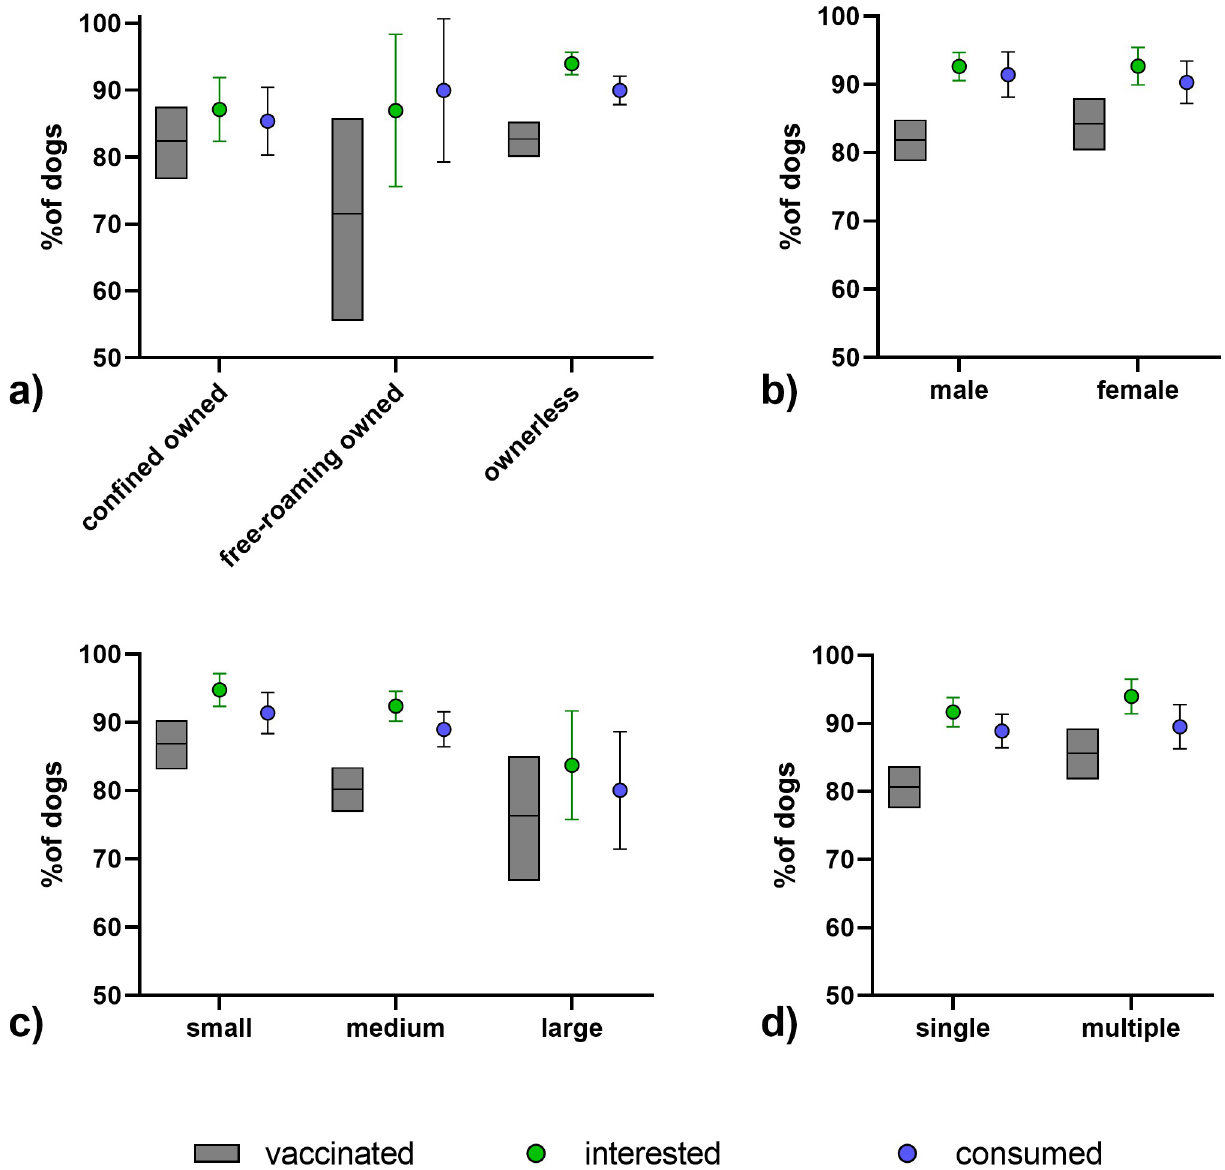
Fig 5. Comparison of bait interest, bait consumption and vaccination according to dog owner status (a), sex (b), size of the dog (c), and the social setting (d). The mean and the 95% confidence limits are indicated.